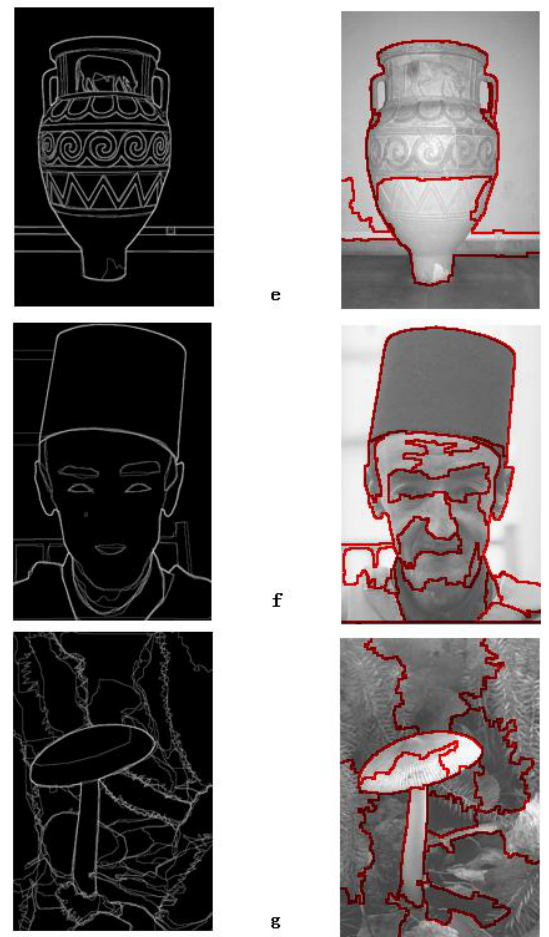
Fig 10. The left column is the human segmentations and the right one is our segmentation result